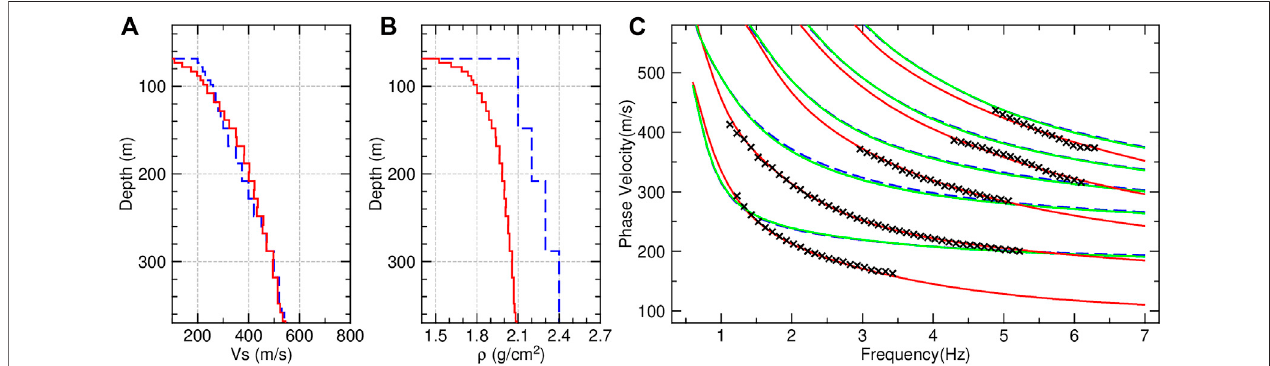
FIGURE 10 | Initial (blue dashed line) and best- fi t (red solid line) geophysical models of the shear-wave velocity (A) and density (B) from the inverted multimode Scholte-wave dispersion curves (C) . The black crosses in (C) denote the picked dispersion curves, the blue dashed line, red solid line, and green solid line denotes the theoretical dispersion curves calculated based on the initial model, the best- fi t model, and the best- fi t density and initial v s model, respectively.